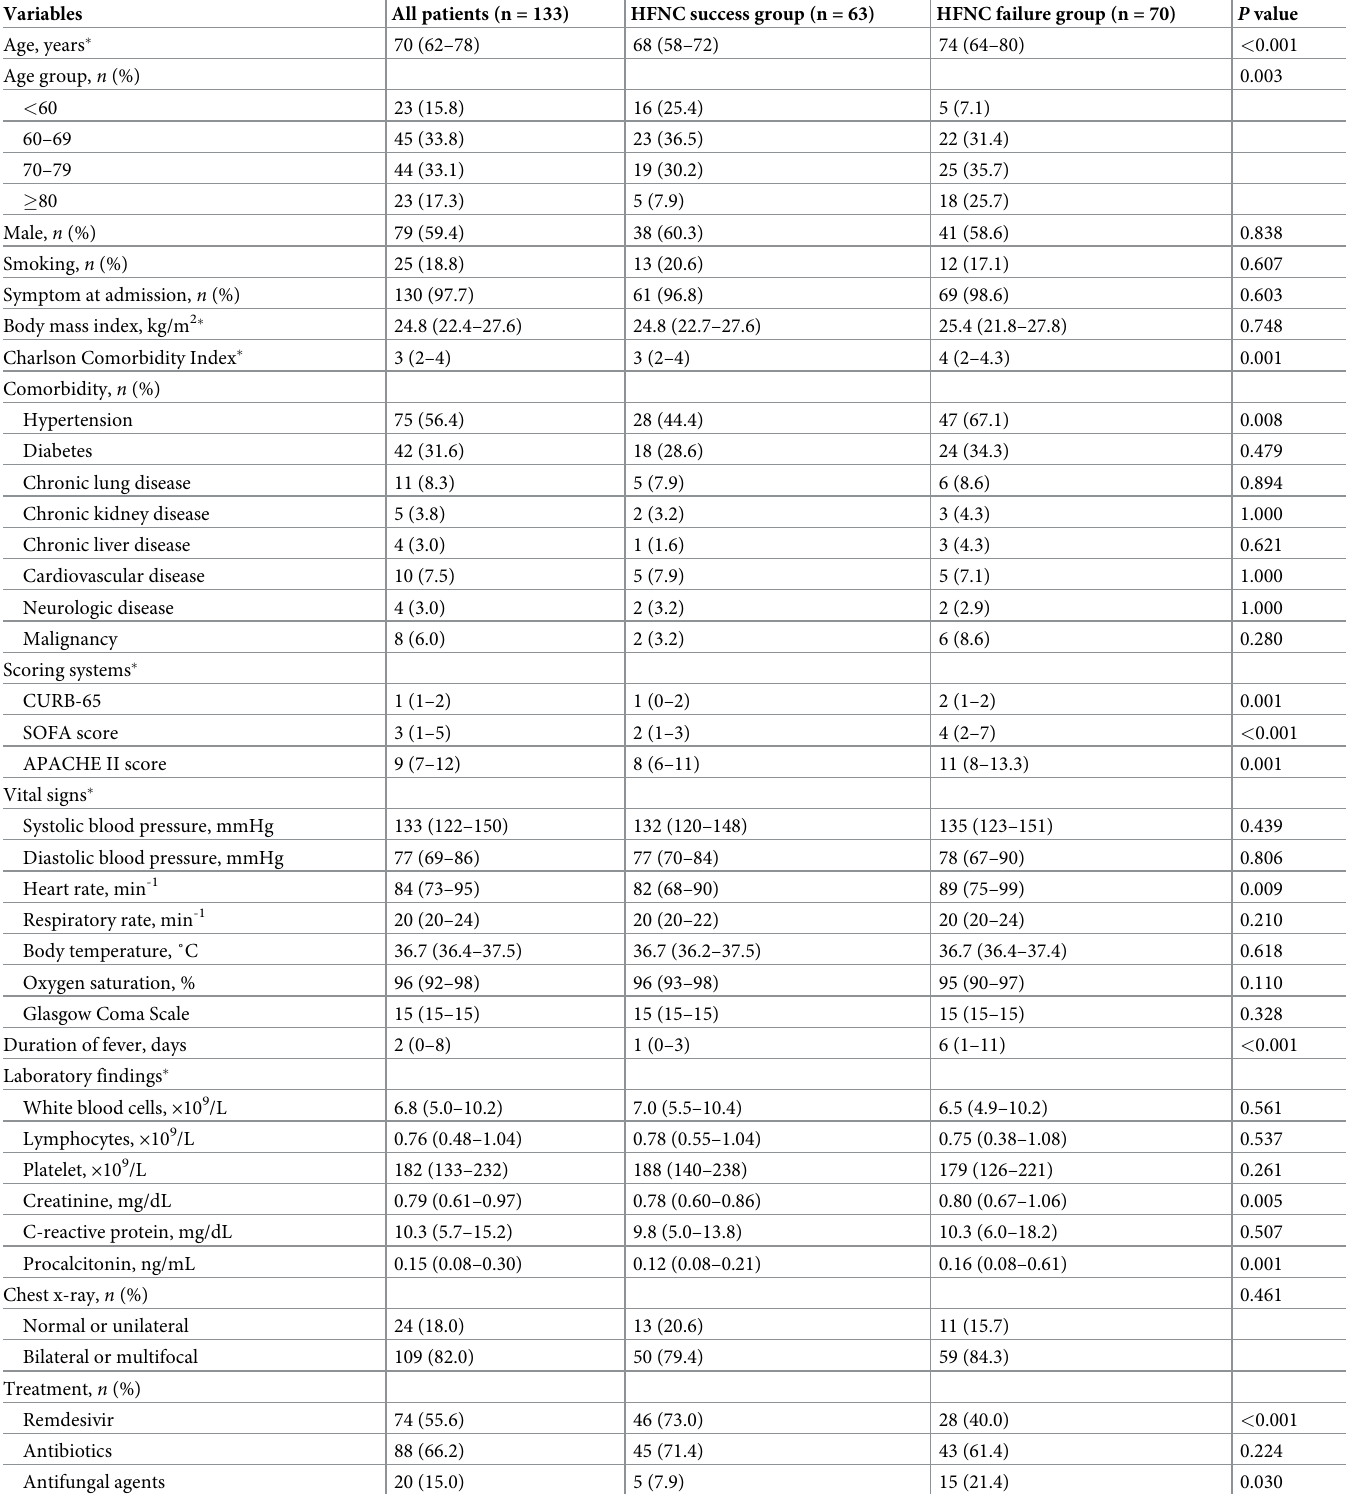
Table 1. Characteristics of patients with SARS-CoV-2 infection (N =